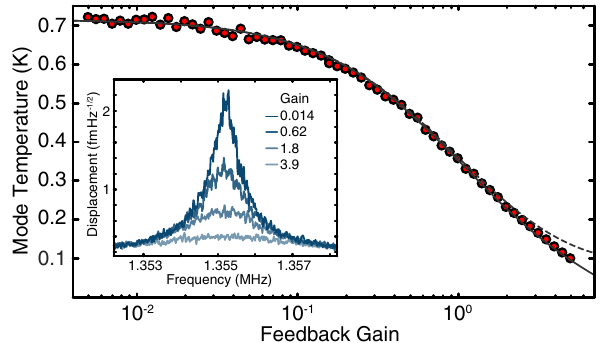
FIG. 5. Feedback cooling of the flexural mode from 715 to 137 mK using superfluid-mediated photoconvective forcing. With a fixed probe power of 1 . 9 μ W, the feedback gain is varied over 3 orders of magnitude, showing good agreement with the estimated mode temperature from in-loop measurements (solid line). The out-of-loop mode temperature is then inferred by a transformation (dashed line) that is derived in the Supplemental Material [36]. Inset: Displacement spectrum of the flexural mode with varying feedback